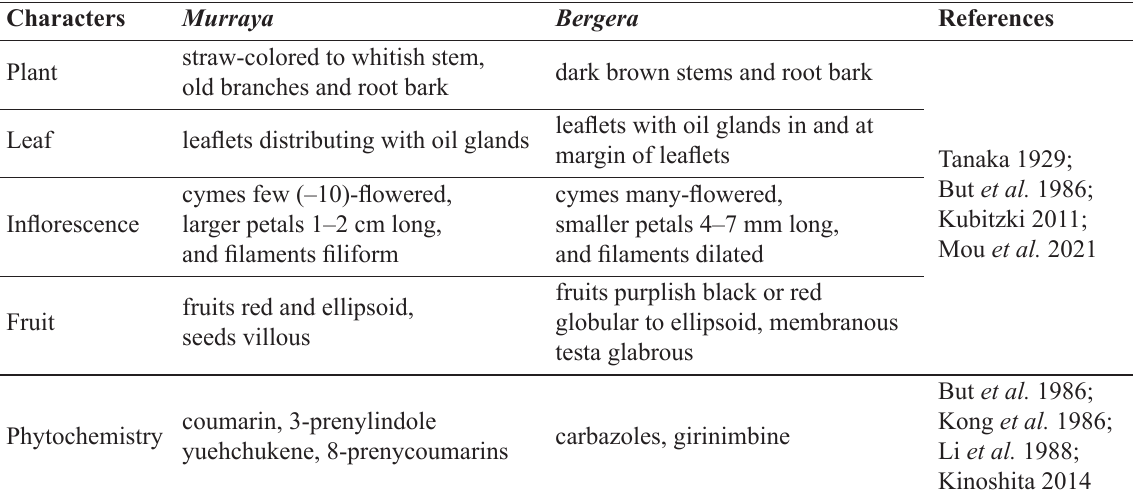
Table 1. The morphological and biochemical differences between two genera Murraya J.Koenig ex L. and Bergera J.Koenig ex